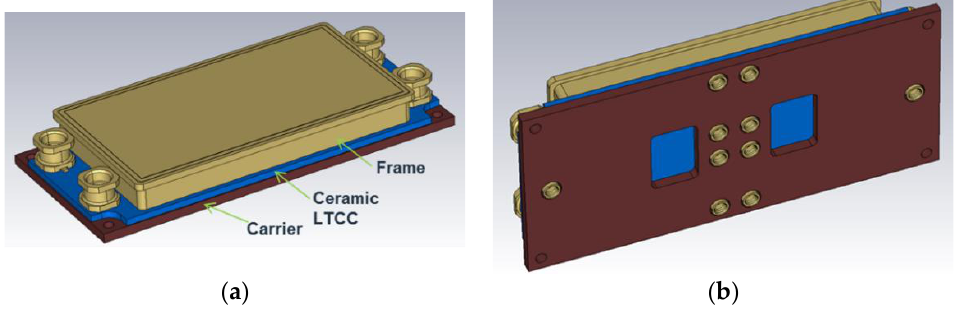
Figure 2. Compact packaging solution for hosting the 4 TRMs. ( a ) Top view. ( b ) Bottom view.